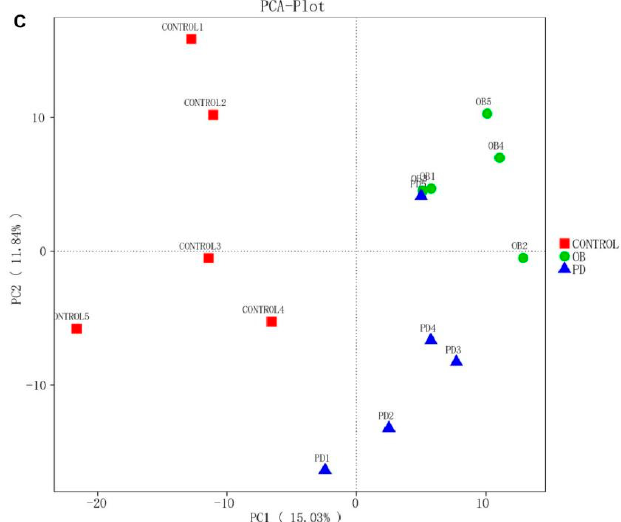
Figure 3. PD modulated the overall Structure of the gut microbiota in ob/ob mice ( A ) Rarefaction curve analysis. The abscissa is the number of sequencings randomly extracted from a sample, and the ordinate is the number of OTUs that can be constructed based on the number of sequencing numbers; ( B ) Plots were generated using the principal coordinates analysis (PCoA); ( C ) principal component analysis (PCA). PCA and PCOA are both based on the OTU level. n = 5.